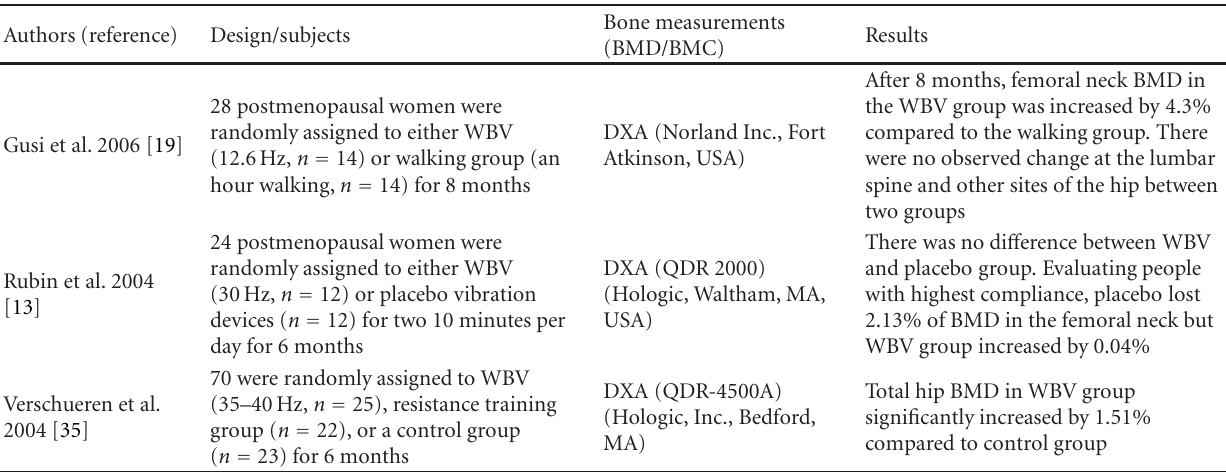
Table 2: Snap-shot of the relevant studies ∗ investigating the relationship of whole-body vibration and BMD of various skeletal sites. Authors